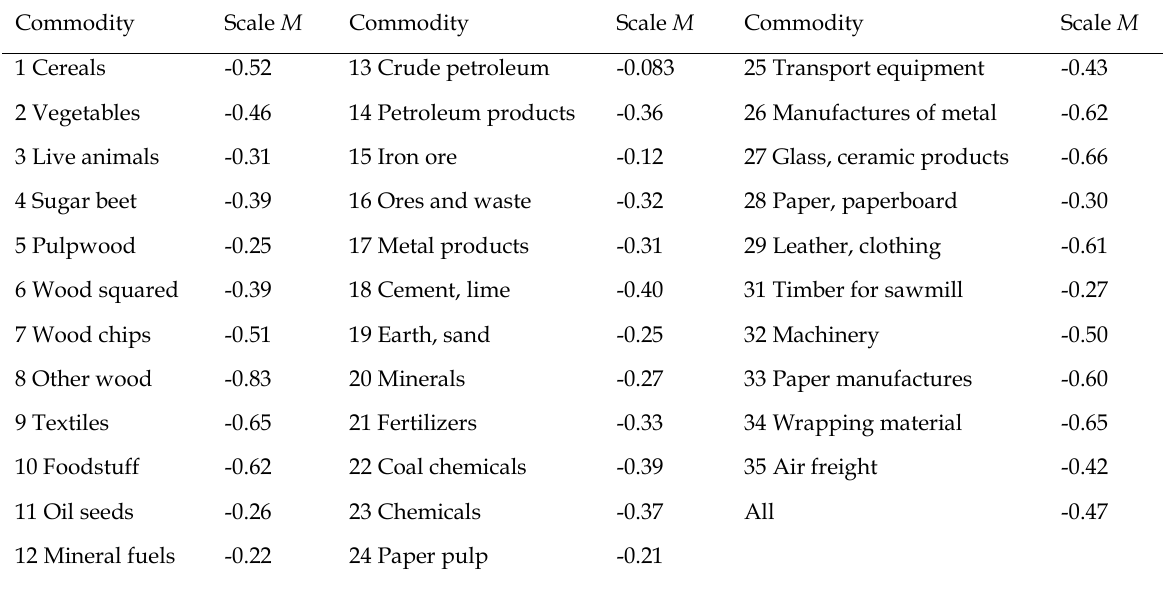
Table 5. Estimated commodity specific scale parameters for total